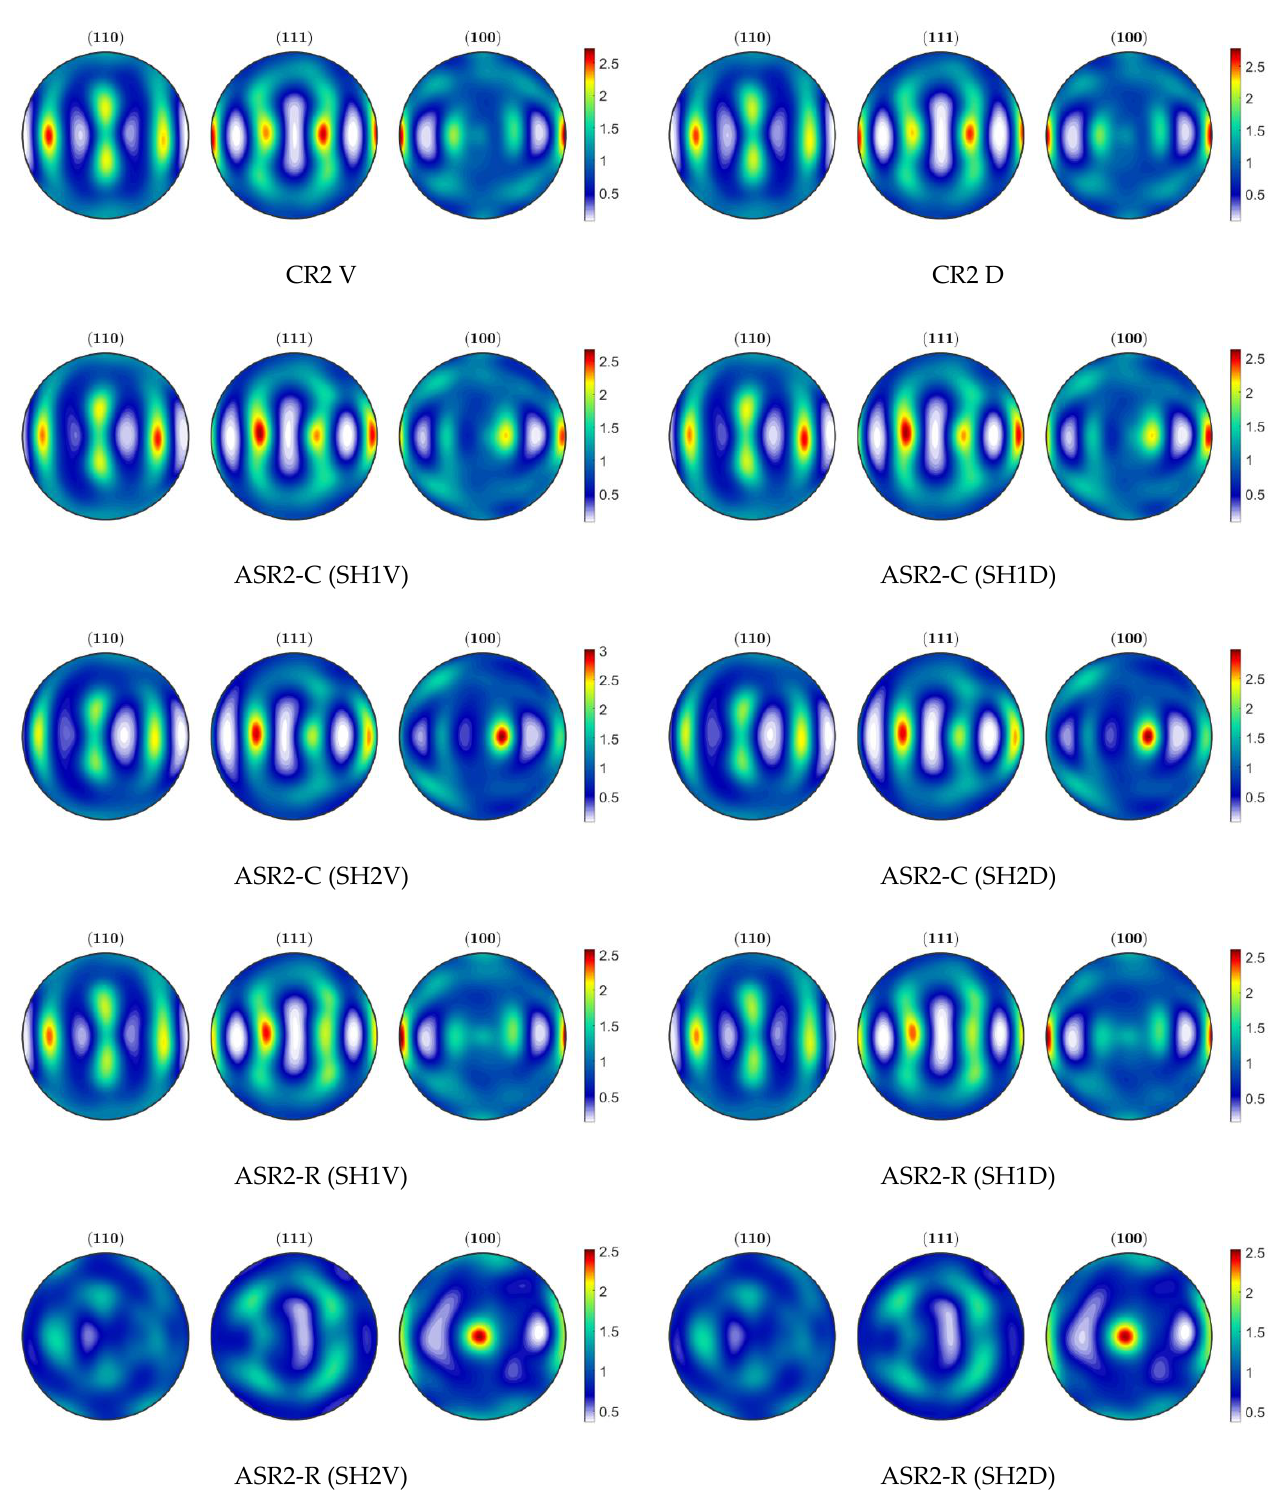
Figure A3. ODF for the second pass with a 20% thickness reduction per pass.